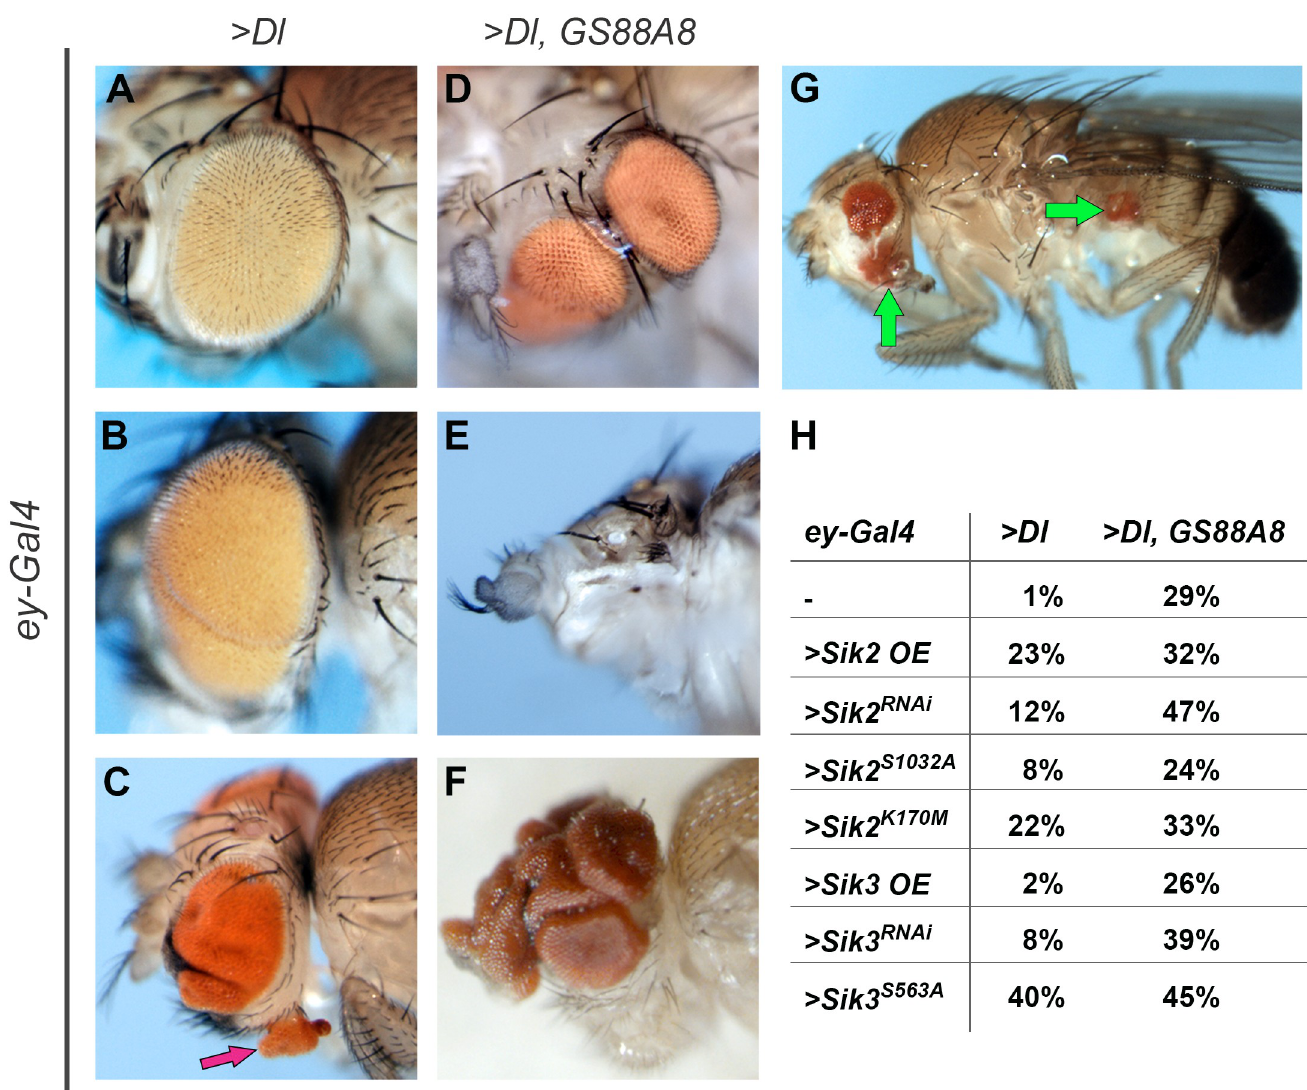
Fig 1. The tumor-like effect of salt inducible kinases (Siks). (A-G) Examples of “sensitized” and “eyeful” crosses’ progeny. (A-C) Examples of flies chosen from the sensitized background ( ey > Dl ) (A) Representative fly from sensitized background showing slight eye overgrowth, accepted as baseline. (B) An example of eye overgrowth, accepted as affected. (C) An example of ectopic eye formation, indicated with a pink arrow. (D-G) Examples of flies chosen from the eyeful background ( ey > Dl , GS88A8 ) (D) An example of split eyes; an eye was split into two on one side of the head. (E) An example of loss of differentiated eye tissue and enlarged antenna. (F) An example of excessive eye growth. (G) A representative example of metastasis. The green arrows indicate proximal and distal metastasis of eye tissue. (H) Sensitized ( ey > Dl ) and eyeful ( ey > Dl , GS88A8 ) flies were crossed with the Sik transgenes: background, crossed with wild type w 1118 (-), Sik2 overexpression ( > Sik2 OE), Sik2 knock-down ( > Sik2 RNAi ), Sik2 constitutively active ( > Sik2 S1032A ), Sik2 kinase-dead ( > Sik2 K170M ), Sik3 overexpression ( > Sik3 OE), Sik3 knock- down ( > Sik3 RNAi ), and Sik3 constitutively active ( > Sik3 S563A ). For each cross, normal eyes (similar to the sensitized background, like in (A)), and affected eyes (eye folding or overgrowth, split eyes or ectopic eye tissue, eye loss or antenna enlargement, and metastasis, like in (B-G)), in the progeny were quantified. The ratio of cumulative number of affected eyes over the total eye number is presented in the table H. The detailed analysis is shown in S1 Table. The full genotypes are listed in S2 Table. Anterior is to the left, ventral is